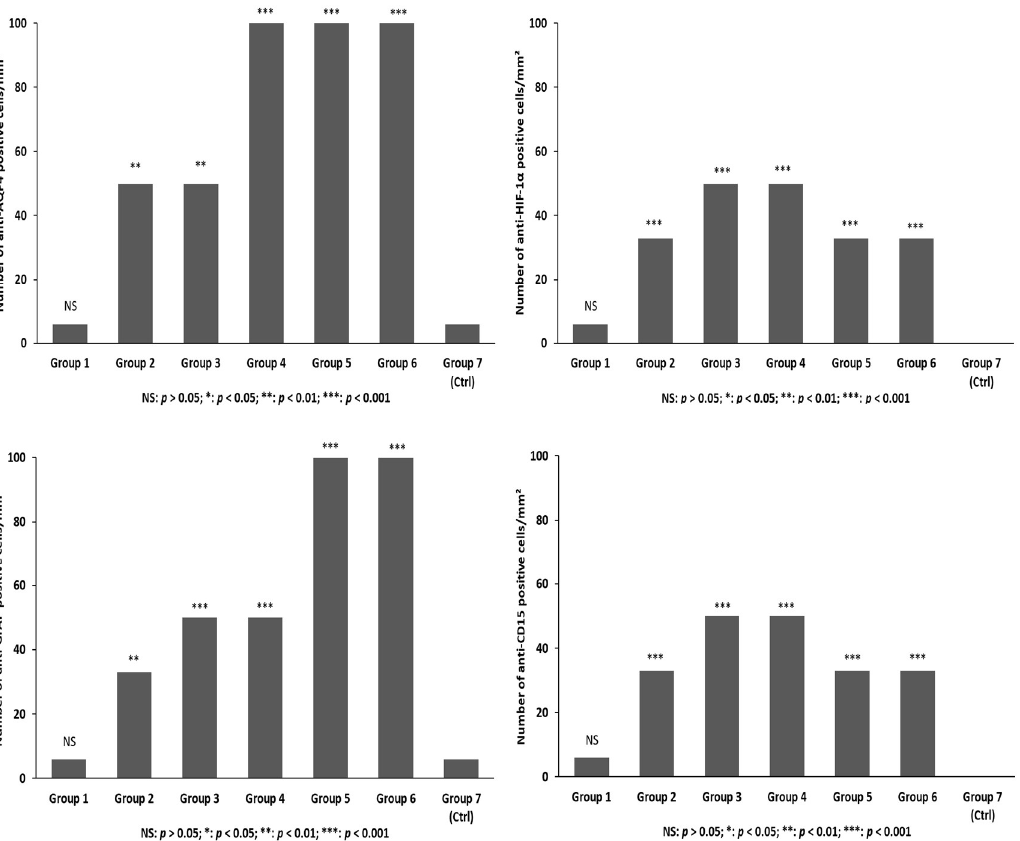
Figure 10. The differences among multiple groups were assessed using one-way ANOVA with a significance level at p < 0.05. Post-hoc comparison between groups was further detected using the least significant difference (LSD) method.